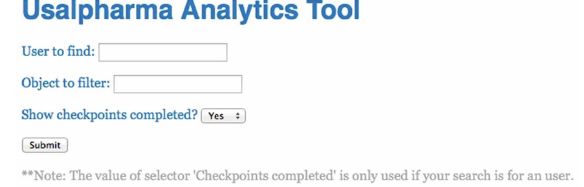
Figure 5: Web application to request data for analysis.